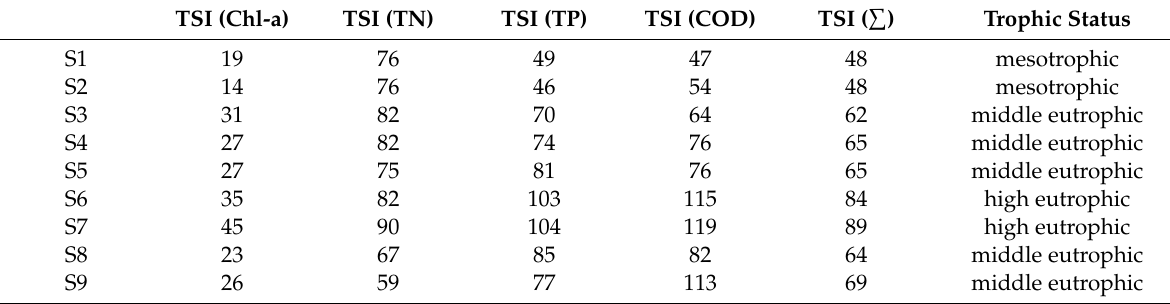
Table 2. Comprehensive trophic index (TSI) of LLRB during ice-covered period in